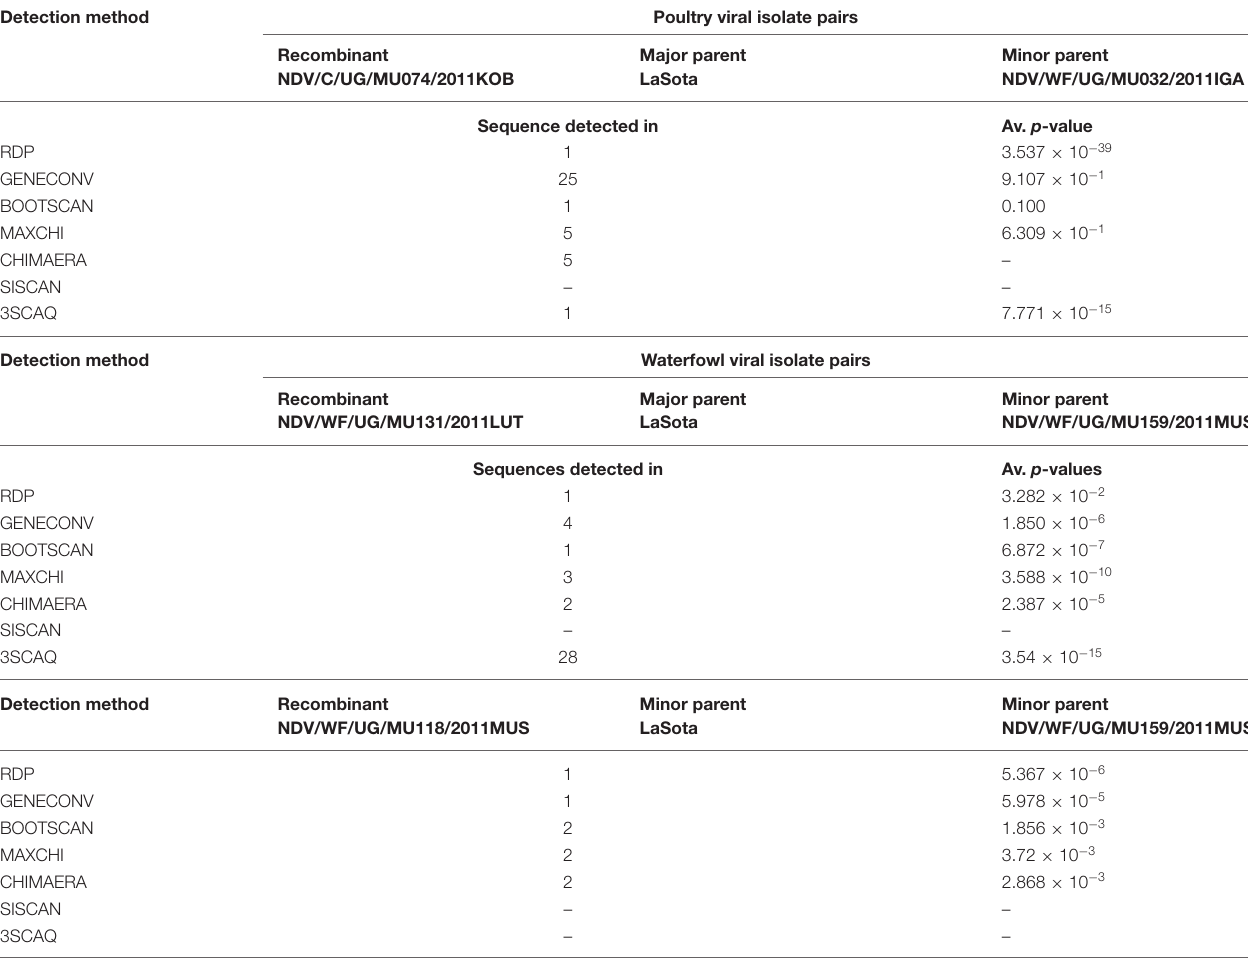
TABLE 7 | Fusion gene recombination confirmation by split decomposition method using local statistical